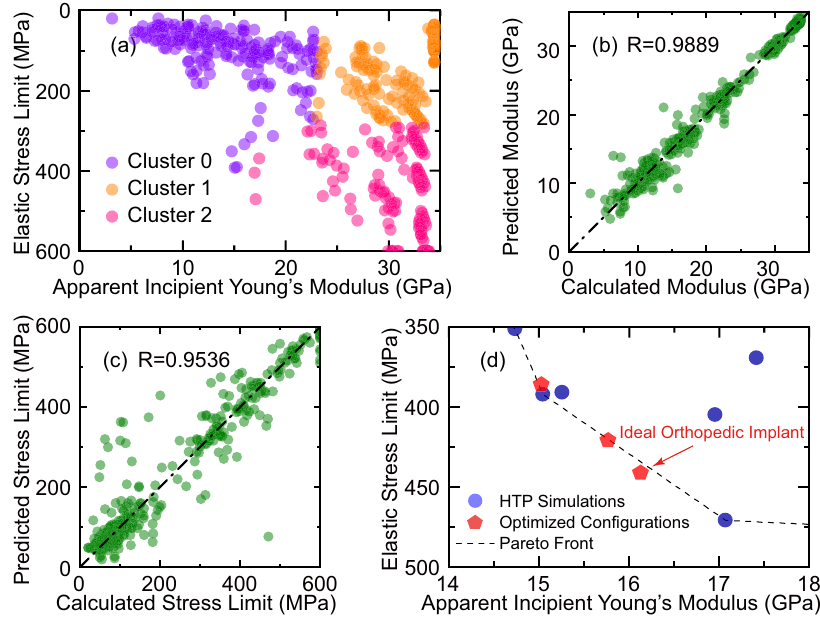
Fig. 4 Machine learning results. a The ML training data is selected according to the K-Means algorithm. Scattering plots of cross-validation performance presented by comparing the results of the ML and the training data of b E I ; c σ L . d The distribution of calculated optimized con fi gurations and training data from HTP phase- fi eld